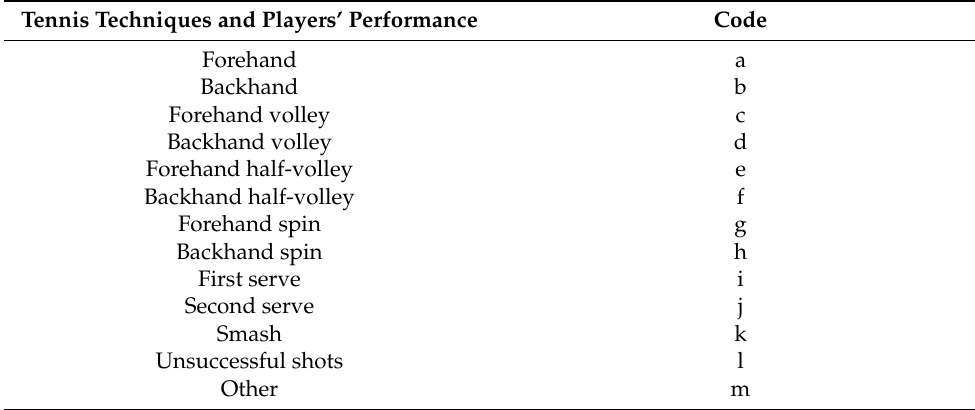
Table 1. Tennis techniques and players’ performance algorithm codes.